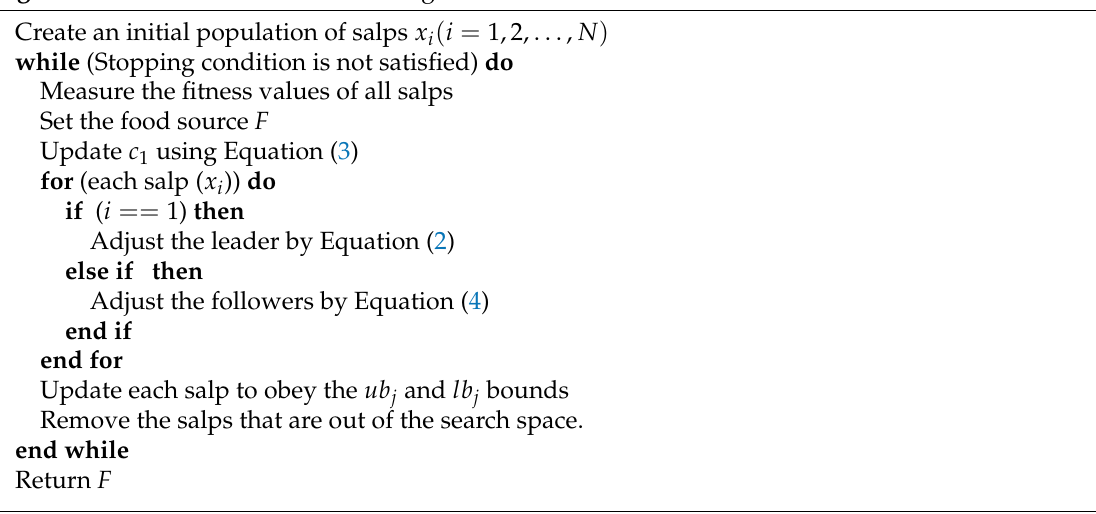
Algorithm 1 Pseudo-code of the SSA